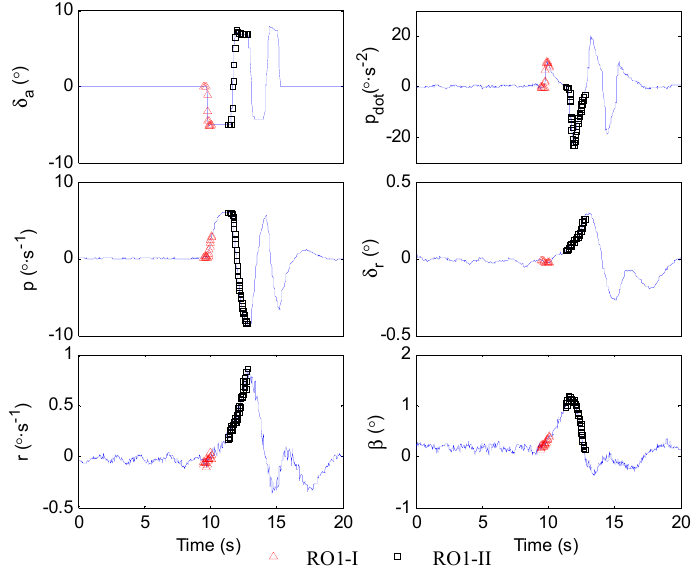
Figure 8. Data segments of response of aileron 3-2-1-1 input for rolling moment derivative identifi- cation.